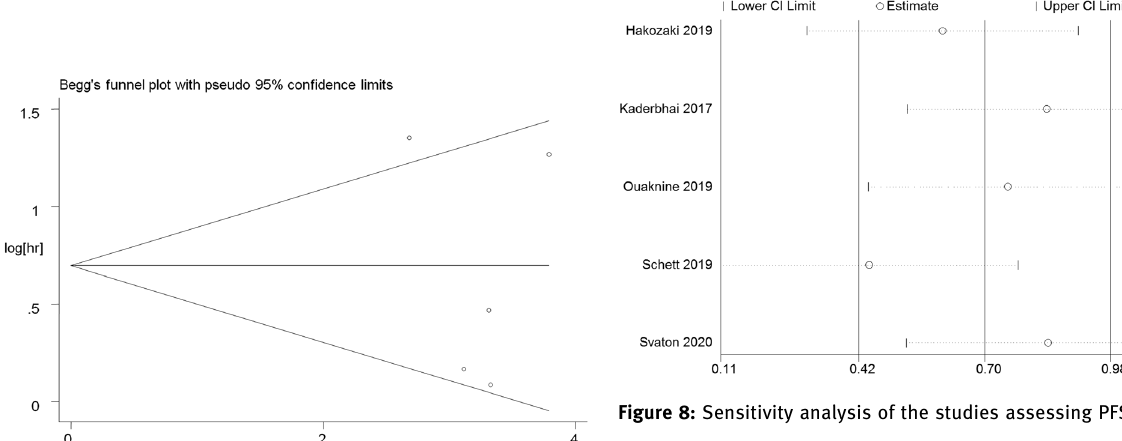
Figure 4: Egger linear regression test for PFS in patients exposed to antibiotics versus those not exposed to antibiotics at the initiation of nivolumab treatment.